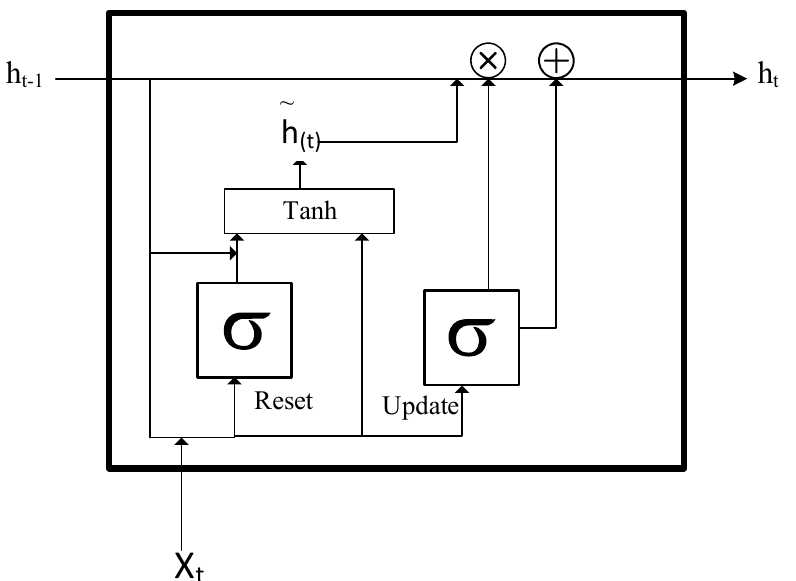
Figure 7. The overall architecture of the Gated Recurrent Unit